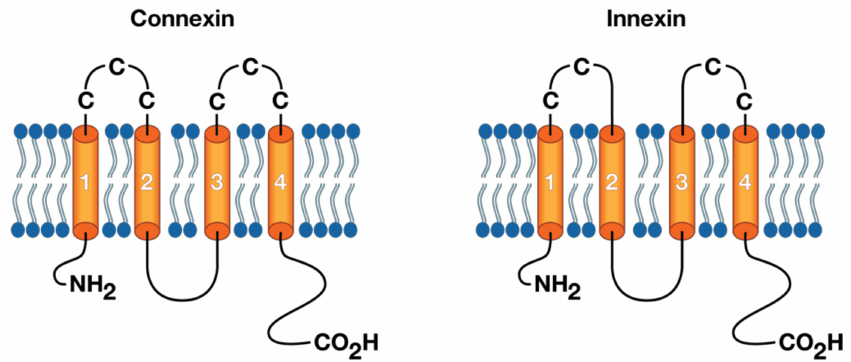
Figure 3. General connexin / innexin structures forming gap junctions and “hemi-channels”. Vertebrates connexins have three cysteine residues (left) in each of their extracellular loops, while invertebrates innexinshaveonlytwocysteinesperloop(right). Bothconnexinsandinnexinshavefourtransmembrane domains (orange tubes) connected by one cytoplasmic loop (black curve), and have both NH 2 and CO 2 H terminals in the